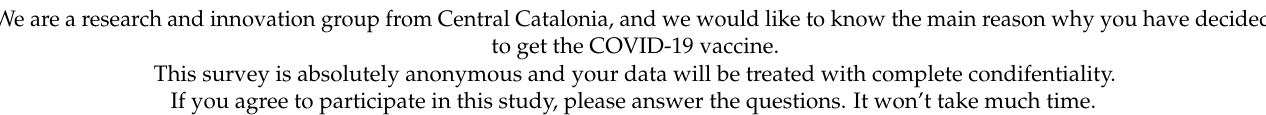
Table A1. Motivation for COVID-19